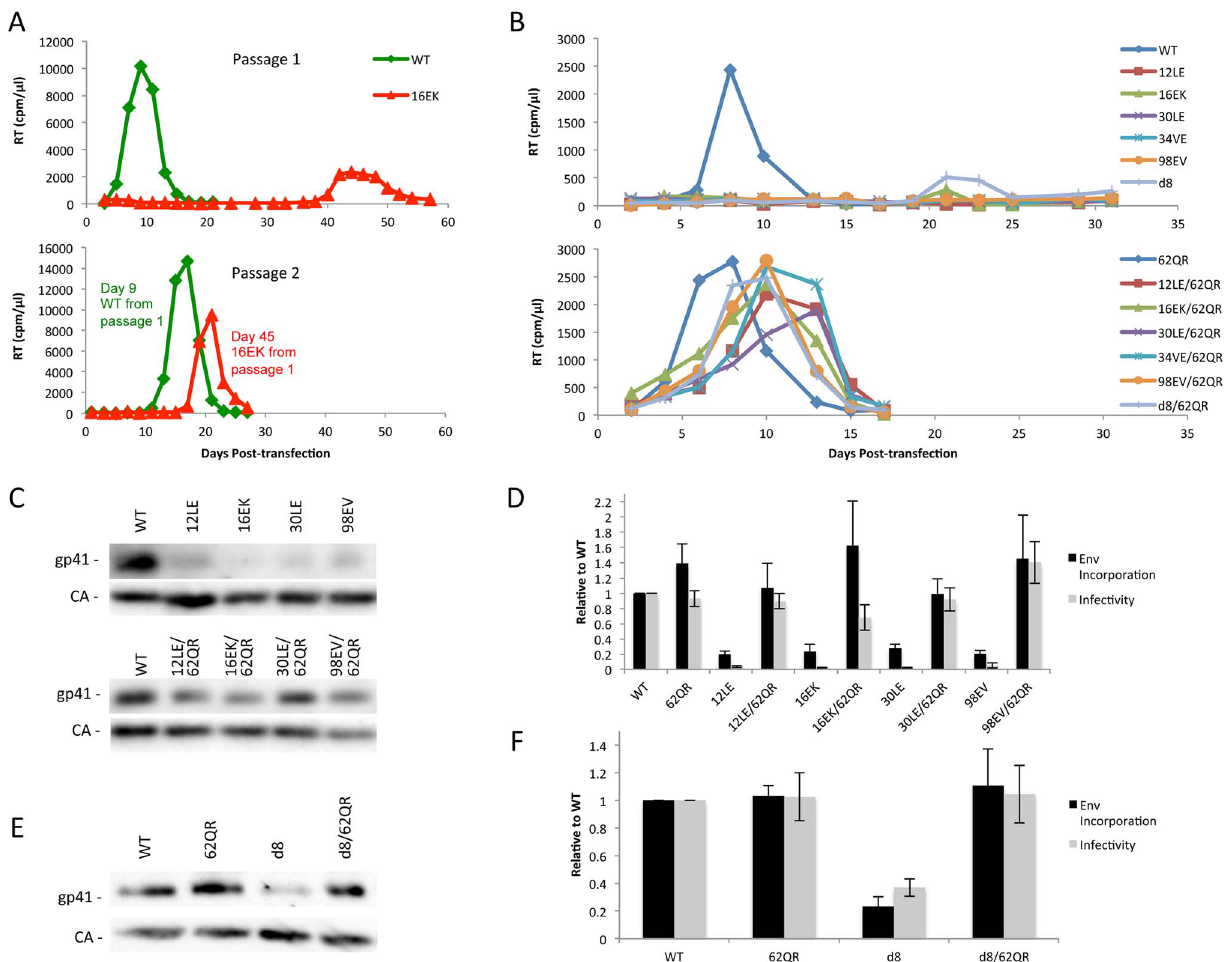
Figure 2. Identification of a second-site mutant capable of rescuing diverse Env-incorporation defective mutants. (A) Jurkat cells were transfected with the indicated molecular clones. At 2-day intervals the cells were split and samples of media were assayed for RT activity. Virus from the WT and 16EK peaks was normalized by RT then used to infect naı¨ve Jurkat cells and replication of the second passage was followed as described above. Genomic DNA was extracted from cells at the time of peak replication in the 16EK samples after both first and second passage cultures, and the MA coding region was amplified by PCR and subjected to DNA sequencing, revealing the original (16EK) and second-site compensatory (62QR) mutations. (B) Jurkat cells were transfected with the indicated molecular clones and replication was monitored as in (A). (C + E) 293T cells were transfected with the indicated molecular clones. At 24 h, supernatants were filtered then virions were pelleted, lysed, and probed by western blotting for gp41 and CA. (D + F) Supernatants were harvested and assayed for infectivity as described in Materials and Methods. Env incorporation was determined as described in Materials and Methods. Infectivity and Env incorporation are expressed relative to the WT value. n=3, + / 2 SEM.